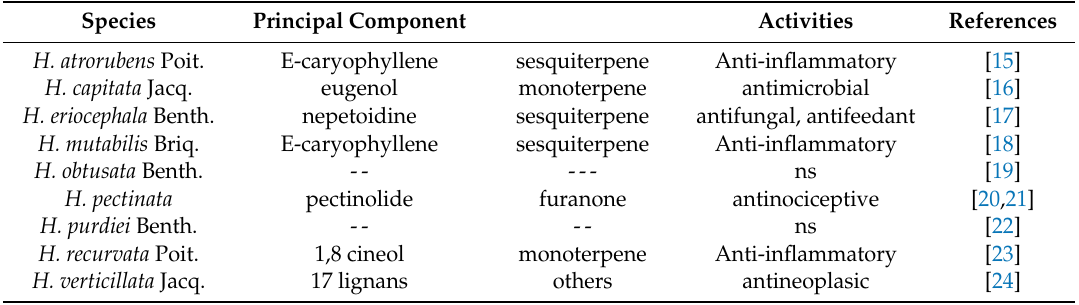
Table 1. Biological activity and chemical components identified (bibliographic references in brackets) for Hyptis species from the Catalogue of Useful Plants of